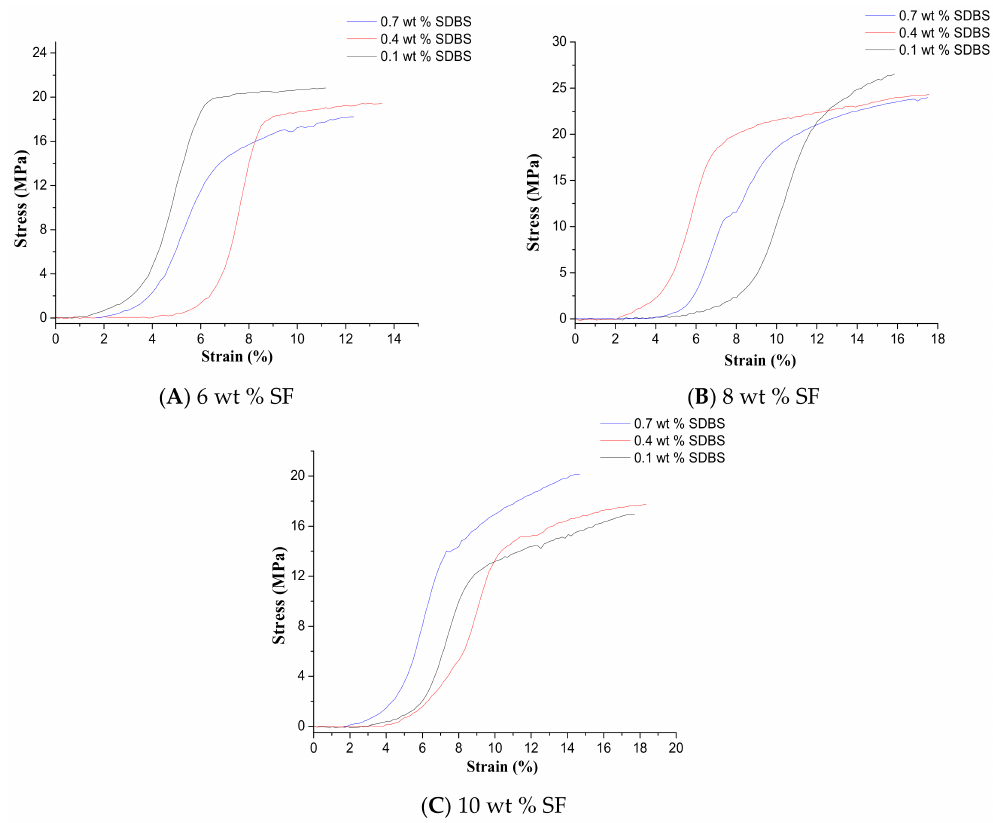
Figure 10. Stress-strain curves of NFMs of the SF nanofibers with SF concentrations of ( A ) 6 wt %; ( B ) 8 wt % and ( C ) 10 wt %, respectively. (Gas flow volume: 50 m 3